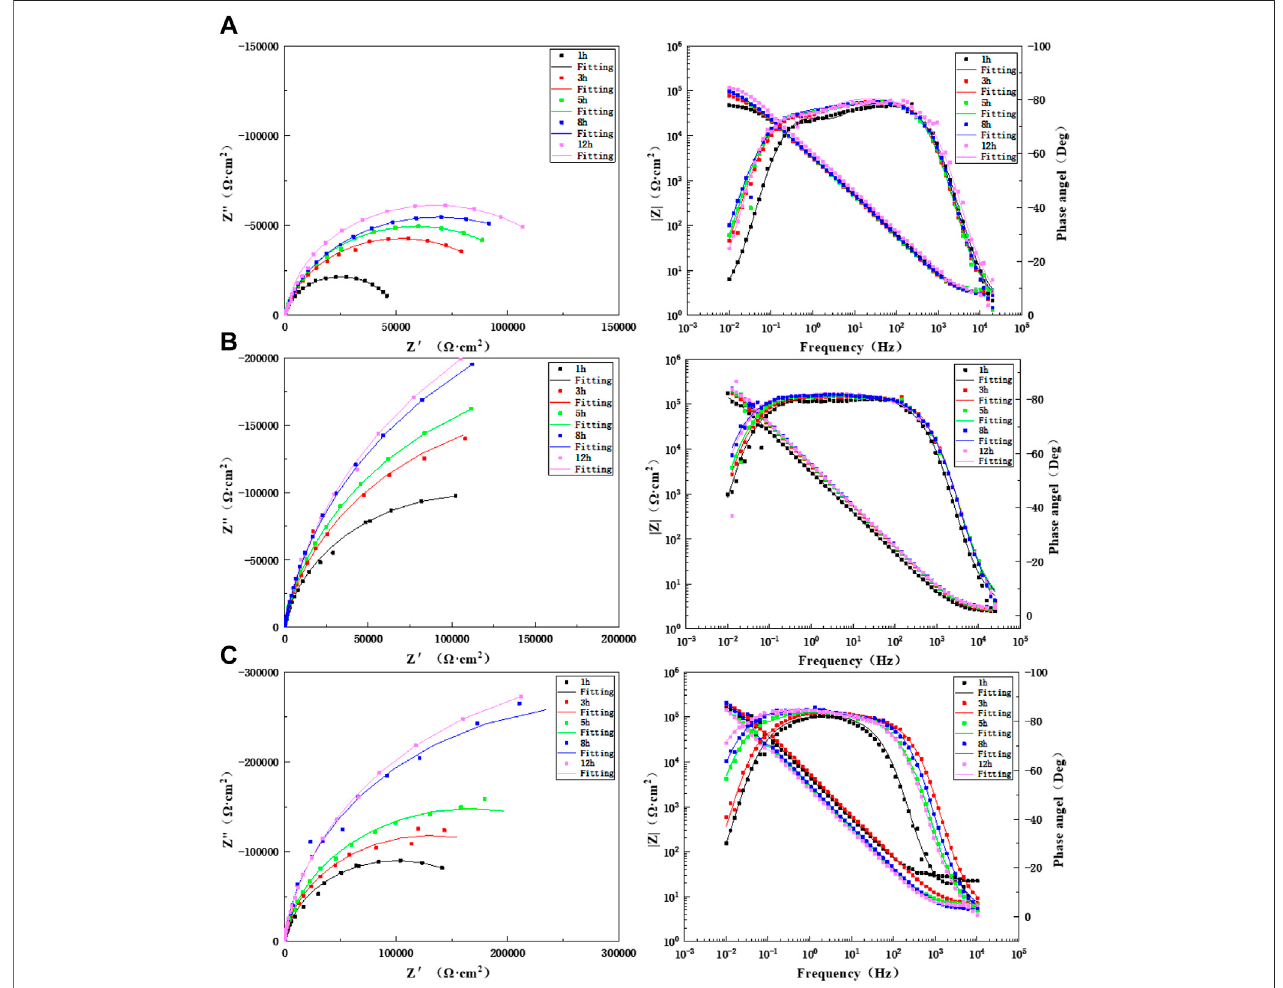
FIGURE 9 | Impedance changes of WM during 12 h of scouring in arti fi cial seawater: (A) 1.85 m/s, (B) 3 m/s, and (C) 6 m/s.